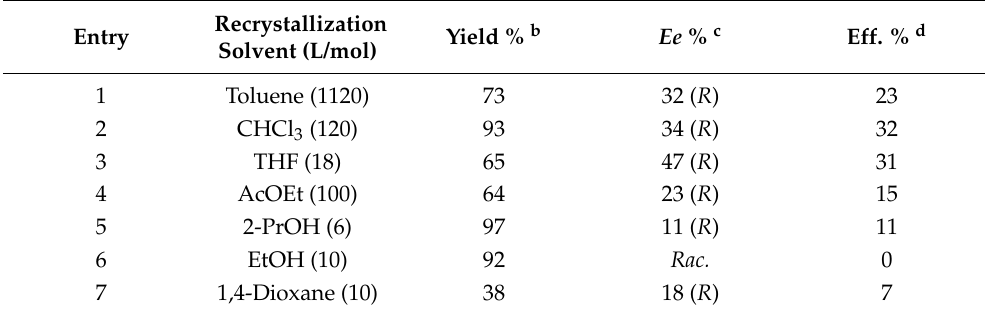
Table 3. Optical resolution of racemic 3-hydroxy-5-phenylpentanoic acid ( rac - 3 ) with ( − )-ADPE a .